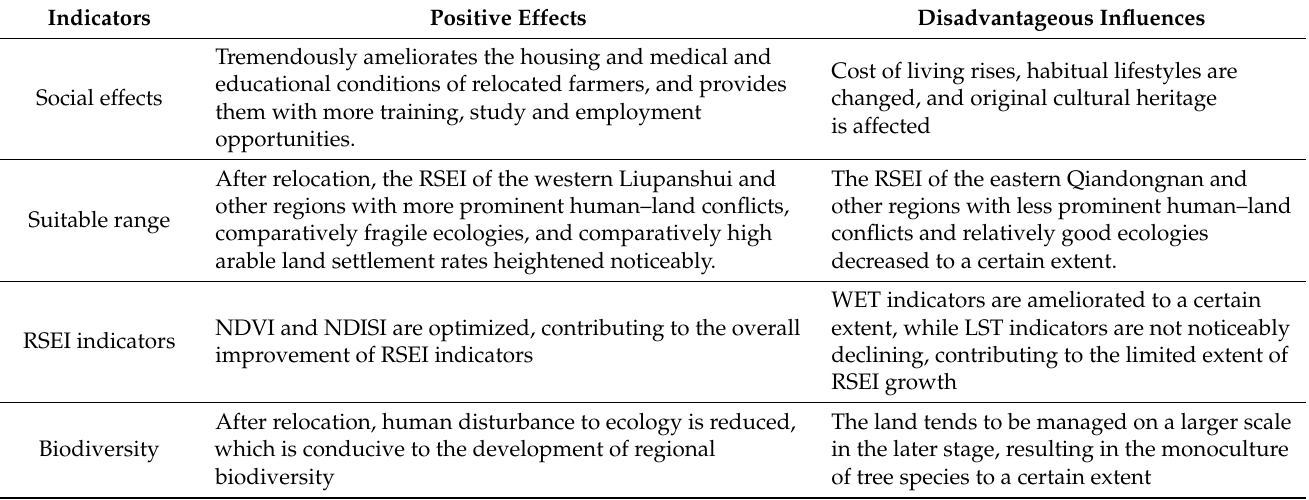
Table 3. Summary table of positive and disadvantageous influences of